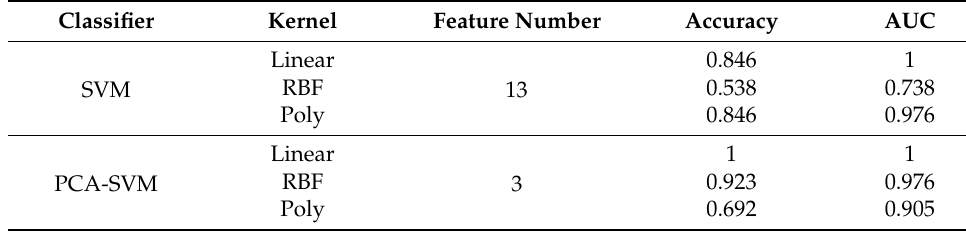
Table 5. Thirteen selected parameters to predict CDR-SB